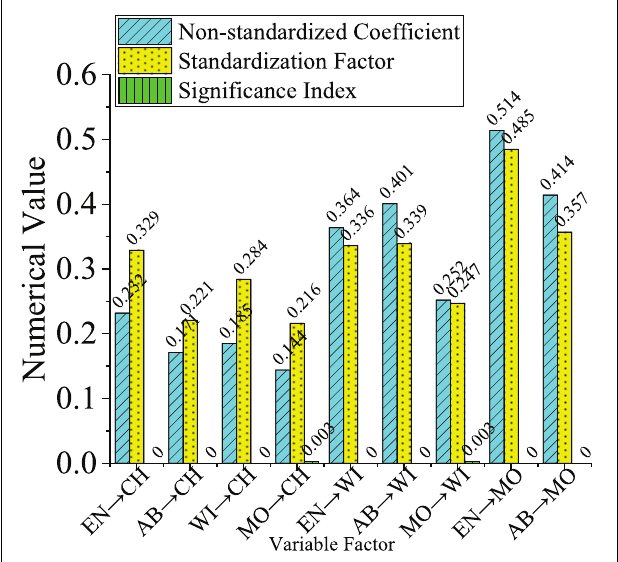
FIGURE 9 | Path coefficient of each variable model (the abscissa in the figure is abbreviated as follows: entrepreneurial environment (EN), entrepreneurial choice (CH), entrepreneurial ability (AB), willingness to act (WI), entrepreneurial motivation (MO), and the arrow indicates that the former affects the